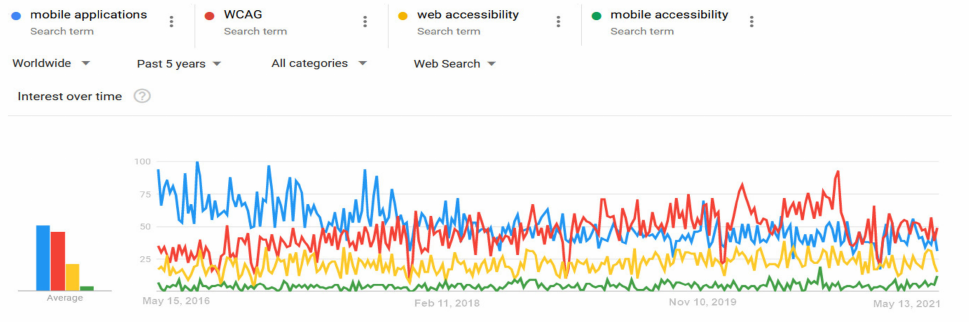
Figure 1. Google Trends search for keyword trends from 2016 to